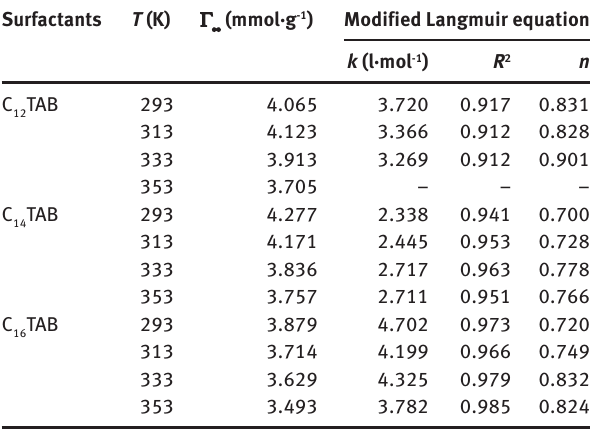
Table 1 Parameters of modified Langmuir equation fitted into the adsorption isotherms of C TAB on GO at different n